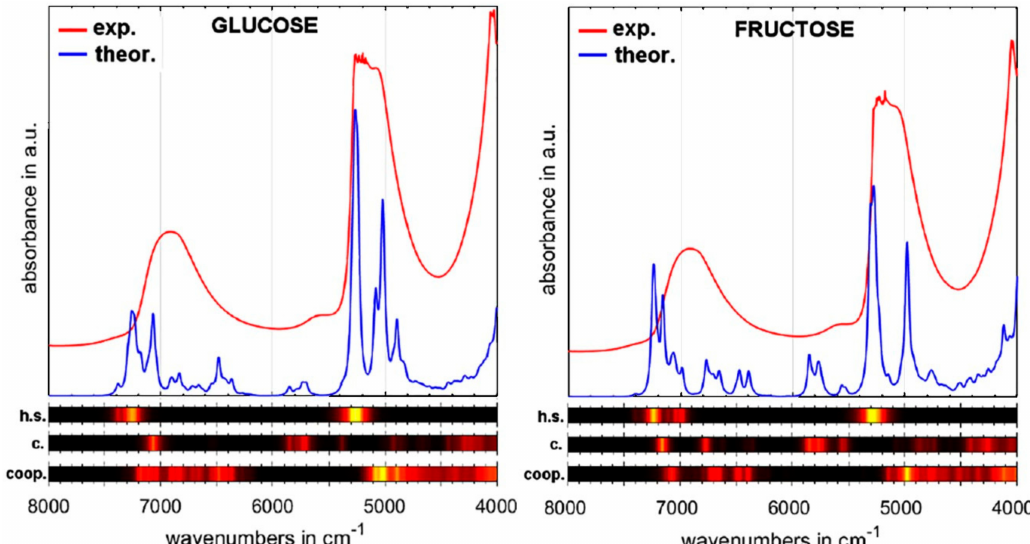
Figure 13. Simulated spectra of the carbohydrate-hydration shell system on the example of glucose and fructose. The color bars represent the relative spectral contributions (color scale: yellow—high; black—none) from: pure vibrations of hydration shell (h.s.); pure vibrations of carbohydrate (c.); cooperative vibrations of carbohydrate and hydration shell (coop). Reproduced in compliance with CC BY 4.0 license from Ref.